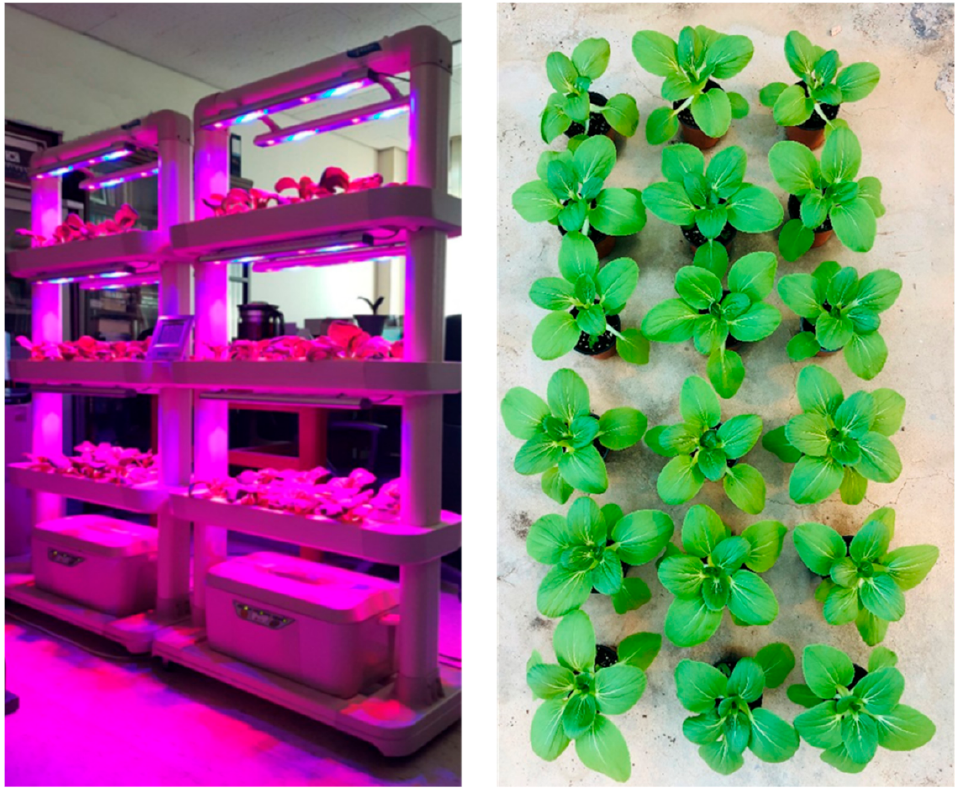
Figure 1. Transplanted pak choi plants in the fully equipped vertical growing bed with the hydro- ponic system ( left ) and in 1-L pots containing the soil mixture ( right ) at room condition and in the greenhouse,